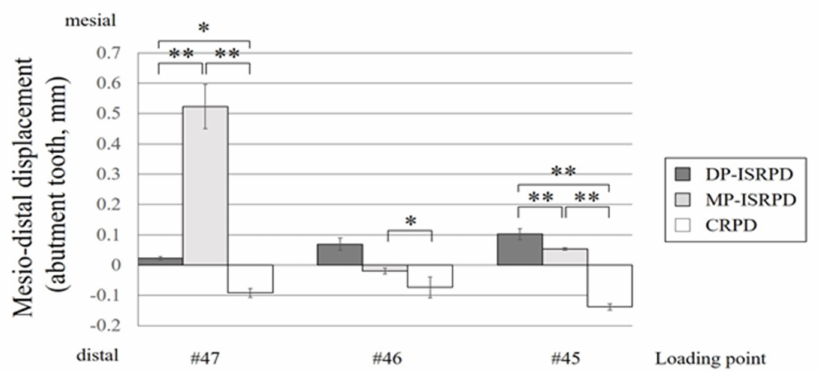
Figure 5. Mesio-distal displacement (mm) of abutment tooth under each loading point (#45, #46 and #47) in conventional removable partial denture (CRPD), mesially positioned implant-supported removable partial denture (MP-ISRPD) and distally positioned implant-supported removable par- tial denture (DP-ISRPD). Error bars represent the standard deviation, and statistical analyses are described as * p < 0.05 and ** p < 0.01, analysis of variance (ANOVA) with Tukey Honestly Significant Difference